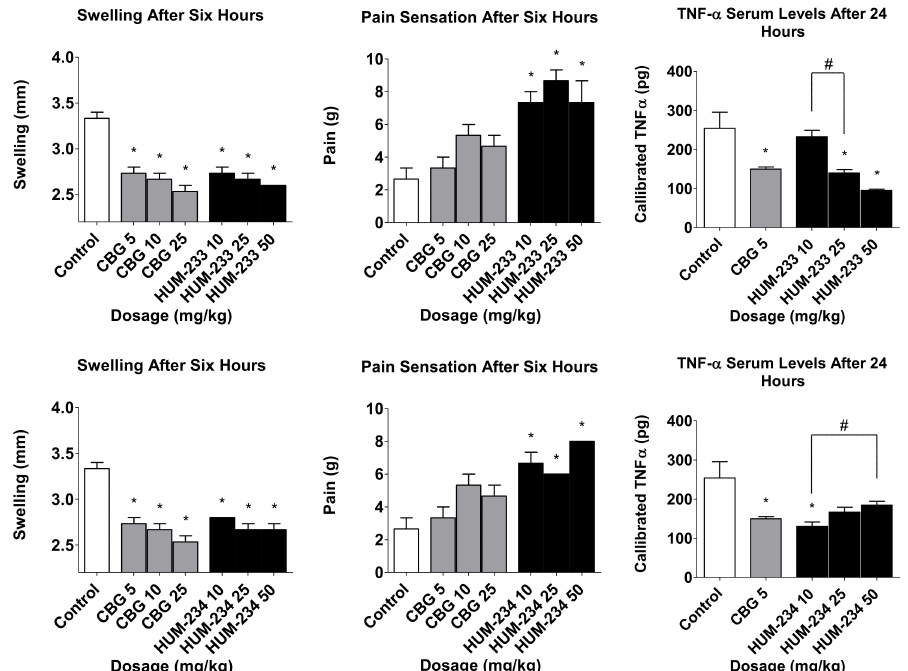
Figure 5. Anti-inflammatory and analgesic evaluation of HUM-233 and HUM-234 (black) compared to CBG (grey) and vehicle control (white). Statistical comparison was carried out by one-way ANOVA ( p -value < 0.0001) and post hoc analysis by Tukey’s test. * p < 0.05 comparing to control group. # p < 0.05 in the indicated